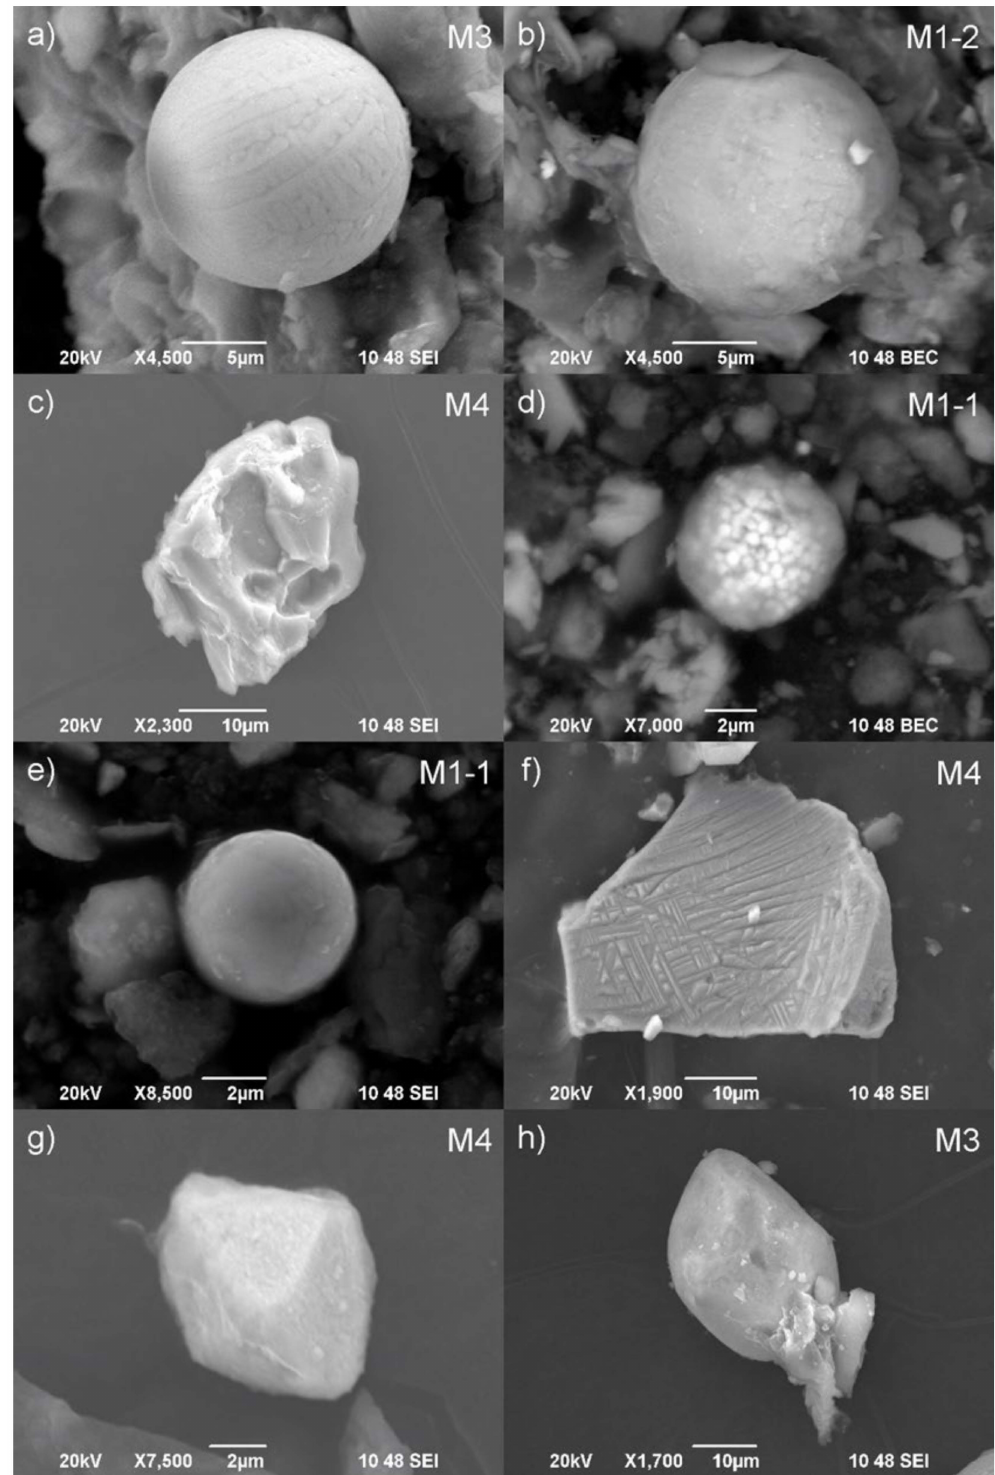
Figure 8. Metal particles from snowmelt water. Presented images are taken in SEI or BSE modes as indicated in the lower right corner of images. The sample code is marked in the upper right corner of each figure. ( a ) Skeletal-dendritic Fe-O sphere; ( b ) Fe-Cr-O sphere; ( c ) Fe-Ca-O particle; ( d ) Fe-S particle (framboidal pyrite); ( e ) Ti-O sphere; ( f ) Fe-Ti-O particle with visible ribs; ( g ) Pb-S (galena); ( h ) Zr-Si-O (zircon). Some spectra are provided in Supplementary Figure